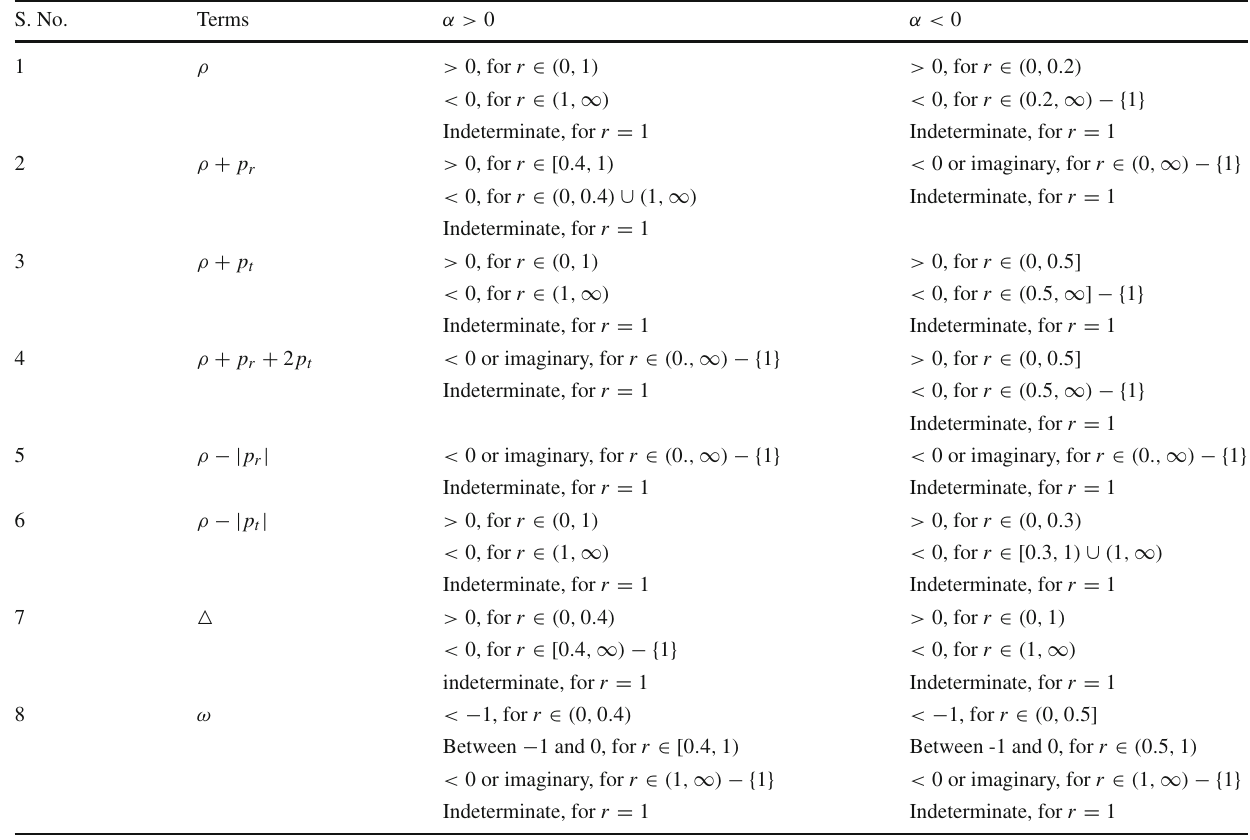
Table 6 Summary of results for φ( r ) = constant with n = − 0 . 1 S.